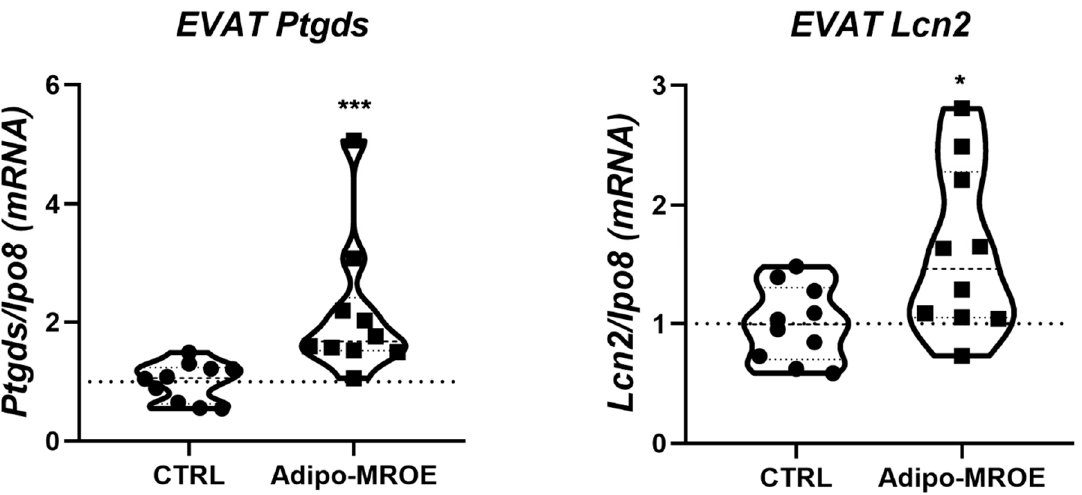
Figure 1. Mineralocorticoid receptor overexpression induces target genes overexpression, showing the existence of min- eralocorticoid receptor (MR) overactivation in adipose tissue. Ipo8 : importin 8; Ptgds : Prostaglandin D2 Synthase; Lcn2 : Lipocalin 2. * p < 0.05, *** p < 0.001, Adipo-MROE vs. Ctrl. Adipo-MROE: adipocyte-MR overexpression in mice.